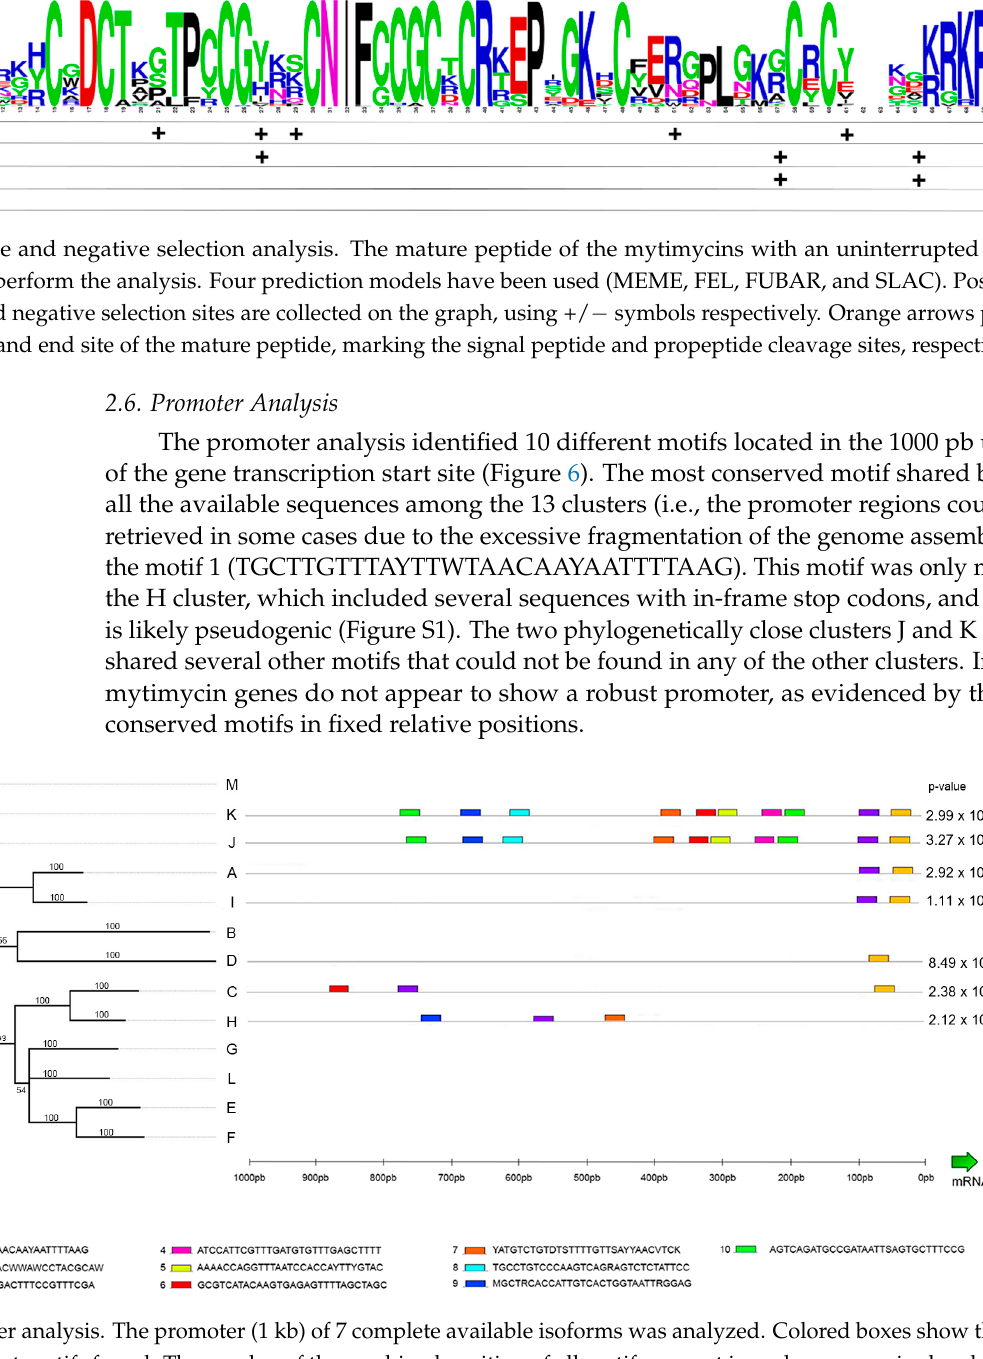
Figure 6. Promoter analysis. The promoter (1 kb) of 7 complete available isoforms was analyzed. Colored boxes show the 10 different significant motifs found. The p-value of the combined position of all motifs present in each sequence is also shown.